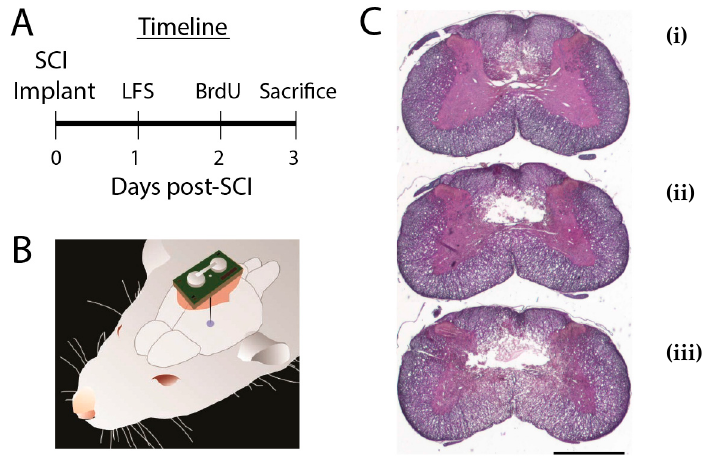
Figure 1. Experimental protocol. ( A ) Experimental timeline. Stimulators were implanted during the same procedure as the C5 contusion but activated one day later in the low-frequency electrical stimulation (LFS) group. ( B ) Schematic illustrating the size and position of the nucleus raphe magnus (NRM) stimulator relative to the rat brain. ( C ) Hematoxylin and eosin-stained sections showing a representative C5 lesion cavity 1 mm rostral to the lesion epicenter ( i ), at the lesion epicenter ( ii ), and 1 mm caudal to the lesion epicenter ( iii ). Scale bar is 1 mm. BrdU, bromodeoxyuridine; LFS, low-frequency stimulation; SCI, spinal cord injury.